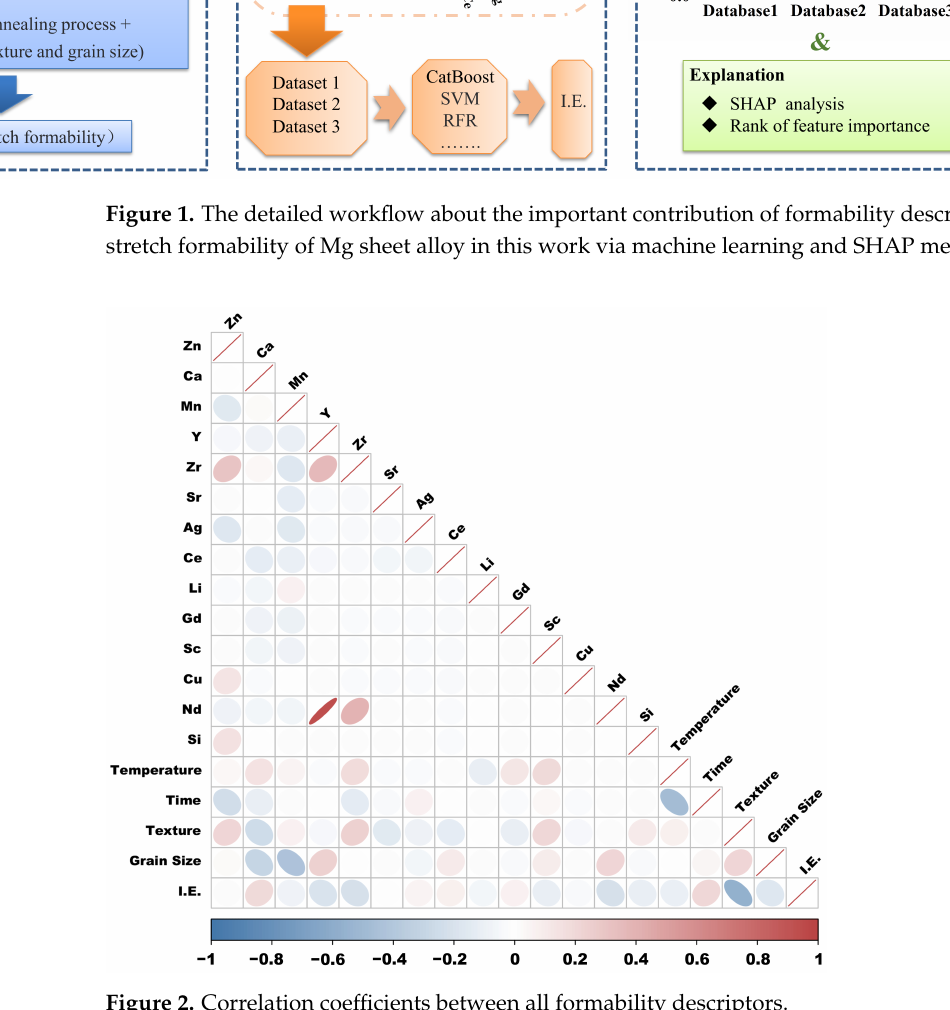
Figure 2. Correlation coefficients between all formability descriptors.